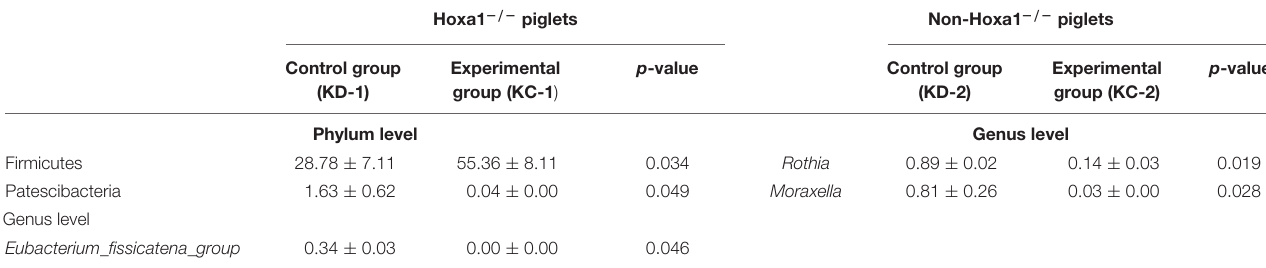
TABLE 4 | The differential jejunal bacterial community of newborn piglets between the control and experimental groups within the same genotype (%).